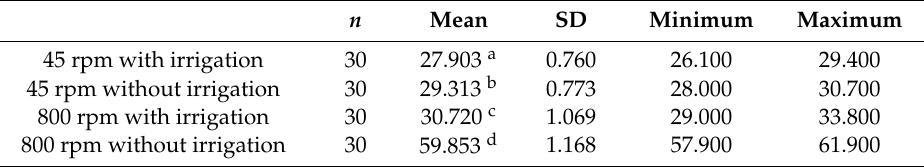
Table 2. Descriptive statistics of the thermographic results ( ◦ C).